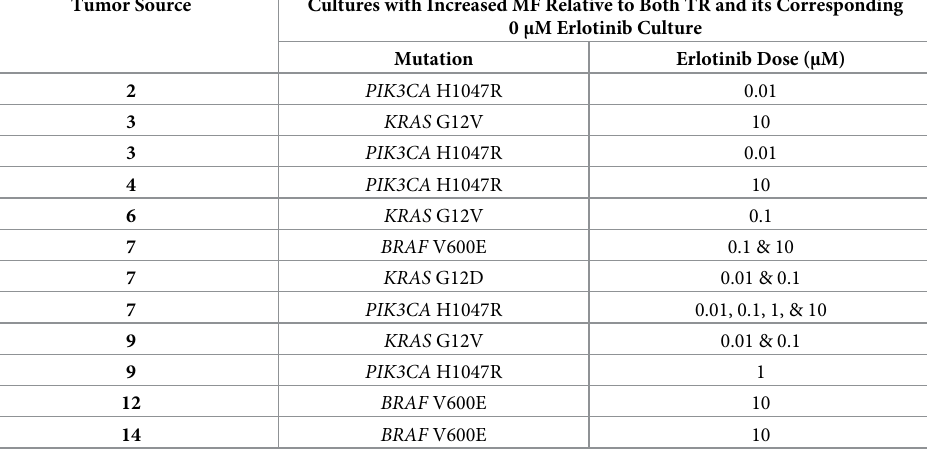
Table 4. Resistance-causing mutations enriched in erlotinib treated cultures compared to TR and corresponding 0 μ M erlotinib control culture. Tumor